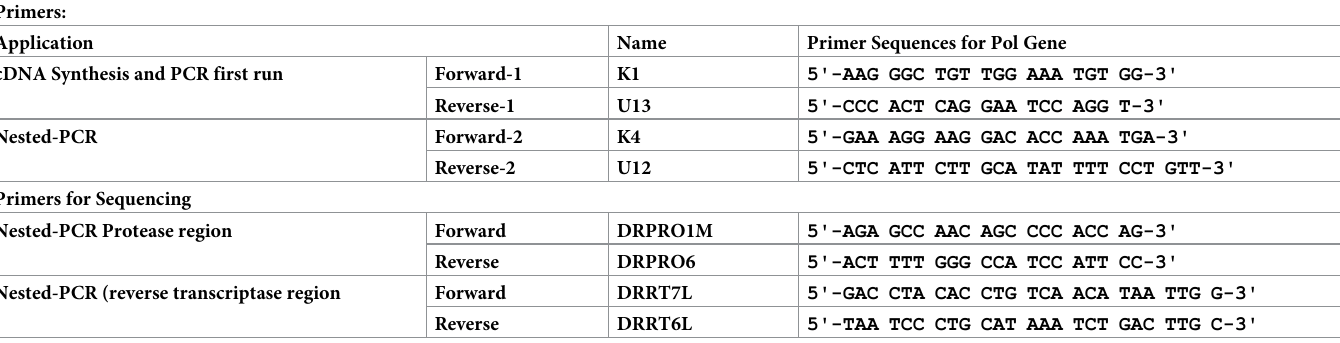
Table 1. Primers used to detect HIV-1 drug resistance mutants.